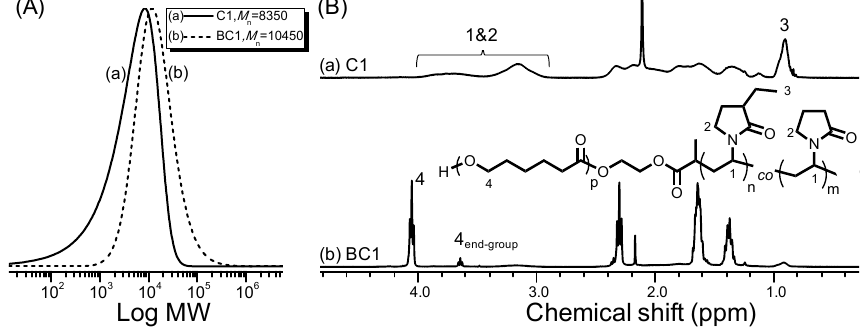
Figure 8. ( A ) GPC traces and ( B ) 1 H NMR spectra (400 MHz, CDCl 3 ) of (a) C1 and (b) BC1 copolymers.